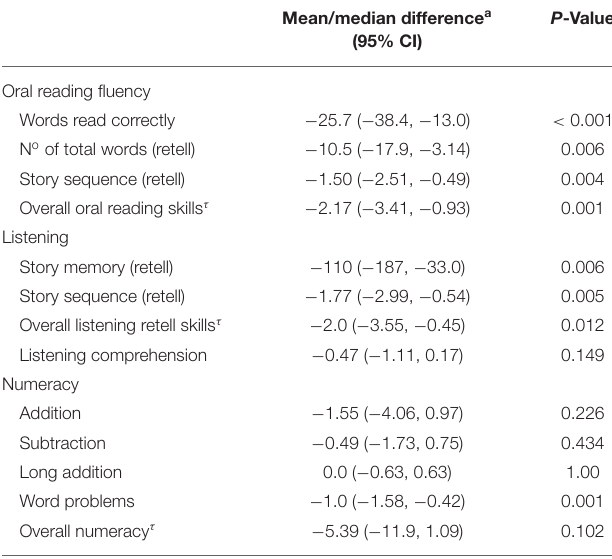
TABLE 2 | Unstandardized regression coefficients (ß) representing mean/median differences in academic outcomes at age 8 between Sleep Disordered Breathing (SDB) and “non-SDB”